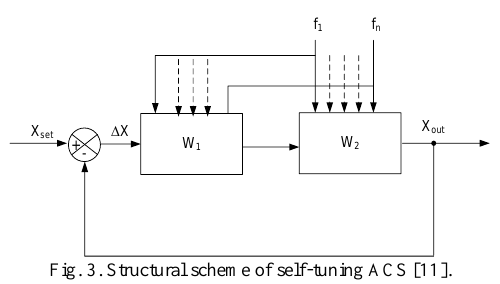
Fig. 3. Structural scheme of self-tuning ACS [11].